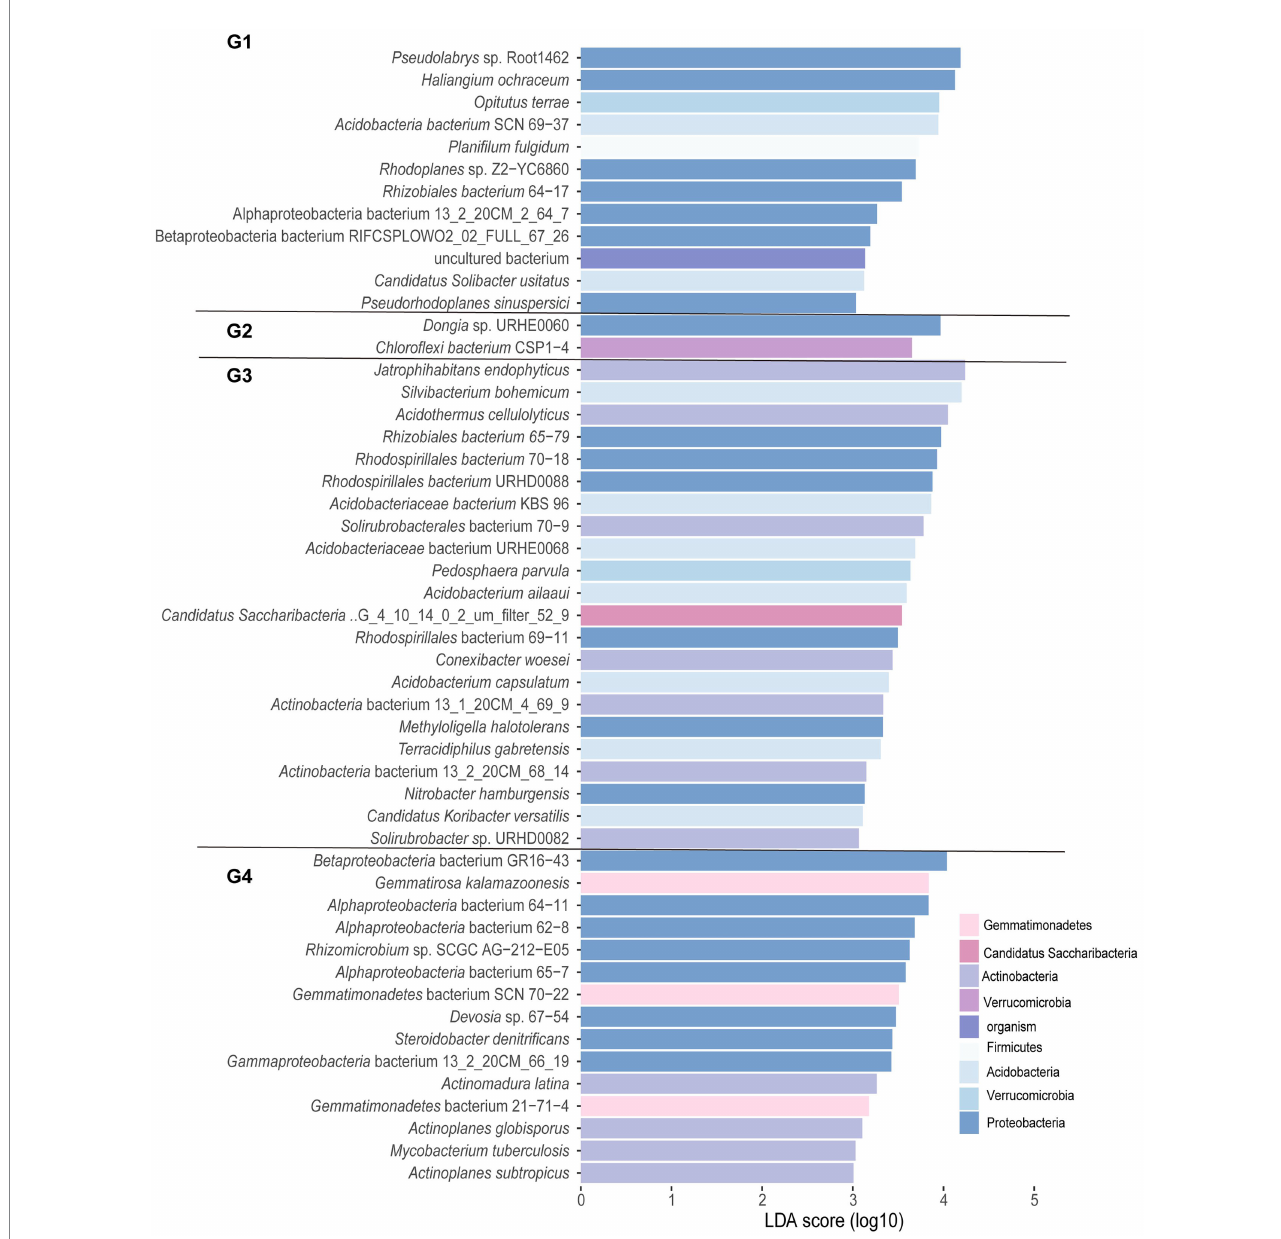
FIGURE 3 Histogram of linear discriminant analysis (LDA) analysis for different groups at the species level. Significance was determined via LDA effect size (LEfSe) analysis at p < 0.05 (Kruskal–Wallis test) and LDA score > 3. G1, 101-14 treated with NaCl; G2, 101-14 treated with ddH 2 O; G3, 5BB treated with NaCl; G4, 5BB treated with ddH 2